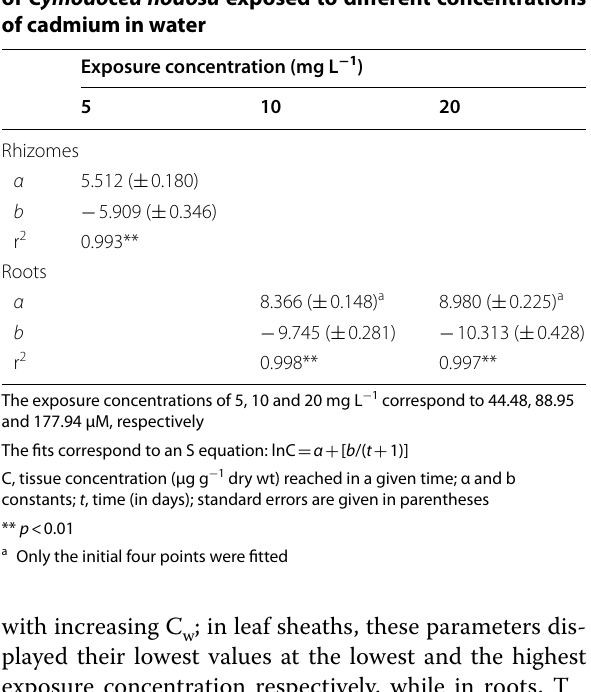
1.0, p < 0.001 and = −